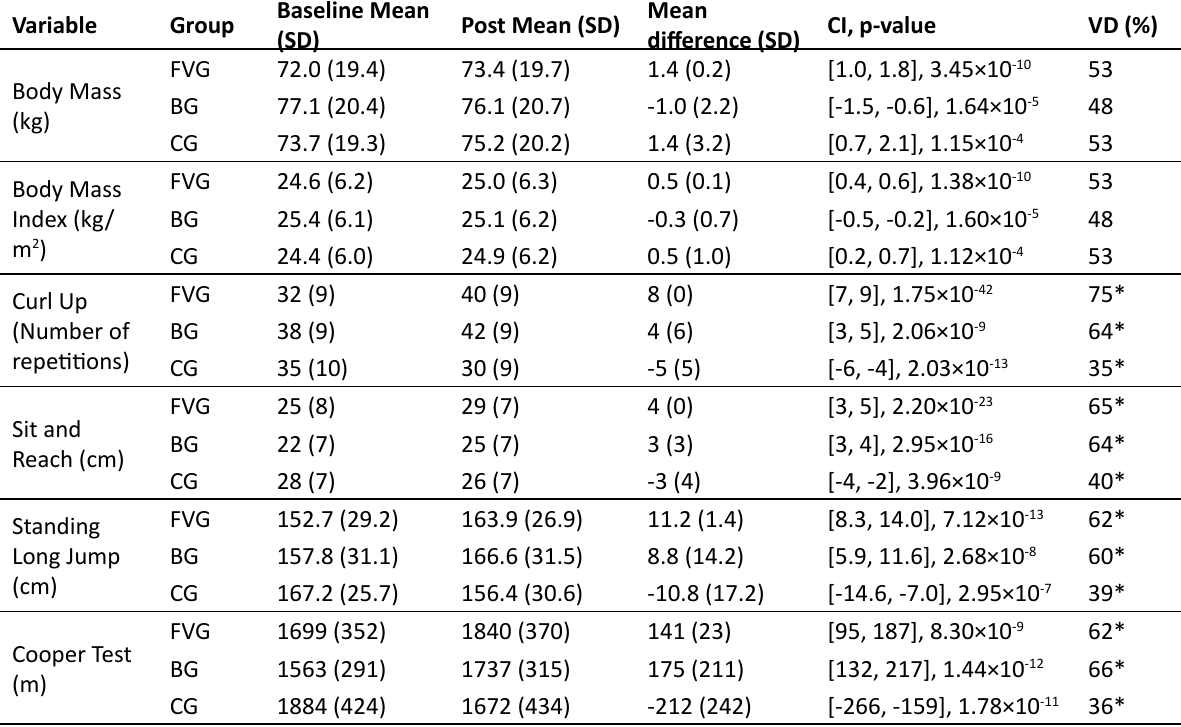
Table 2. Baseline vs post comparisons, football & volleyball (FVG, n=169), badminton (BG, n=97), control (CG, n=80) Variable